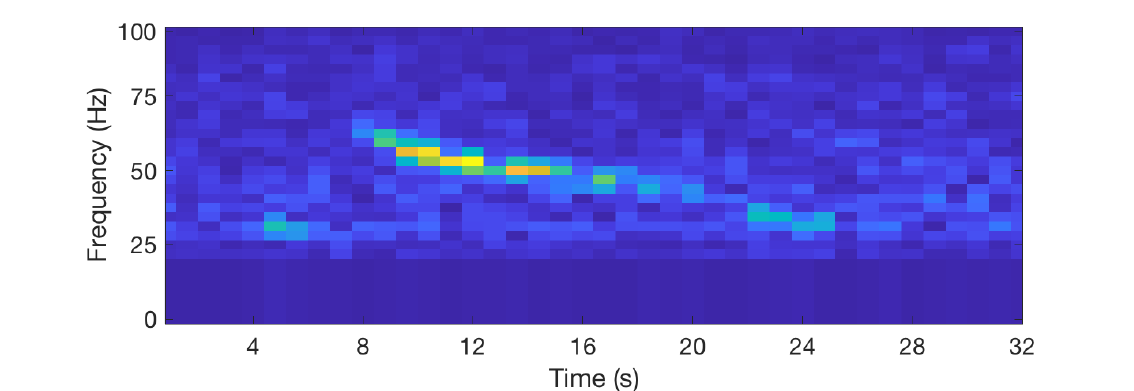
Figure 9. Spectrogram of a blue whale D-call with low frequencies removed.